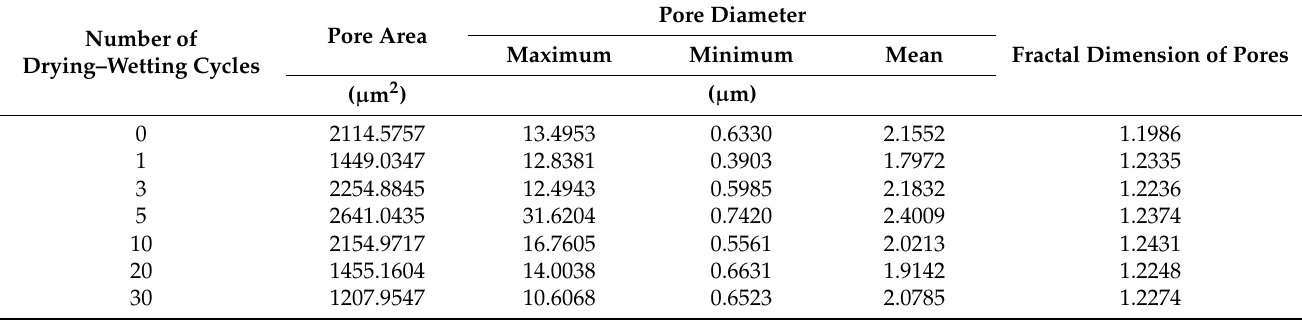
Table 8. Microstructural parameters of Yili loess samples after different drying–wetting cycles.